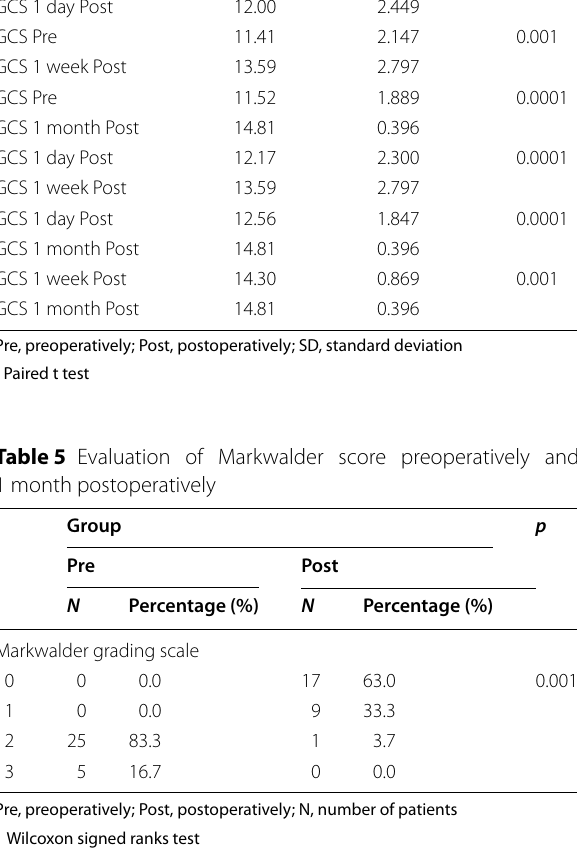
Table 6 Evaluation of motor power preoperatively and throughout the postoperative follow-up period